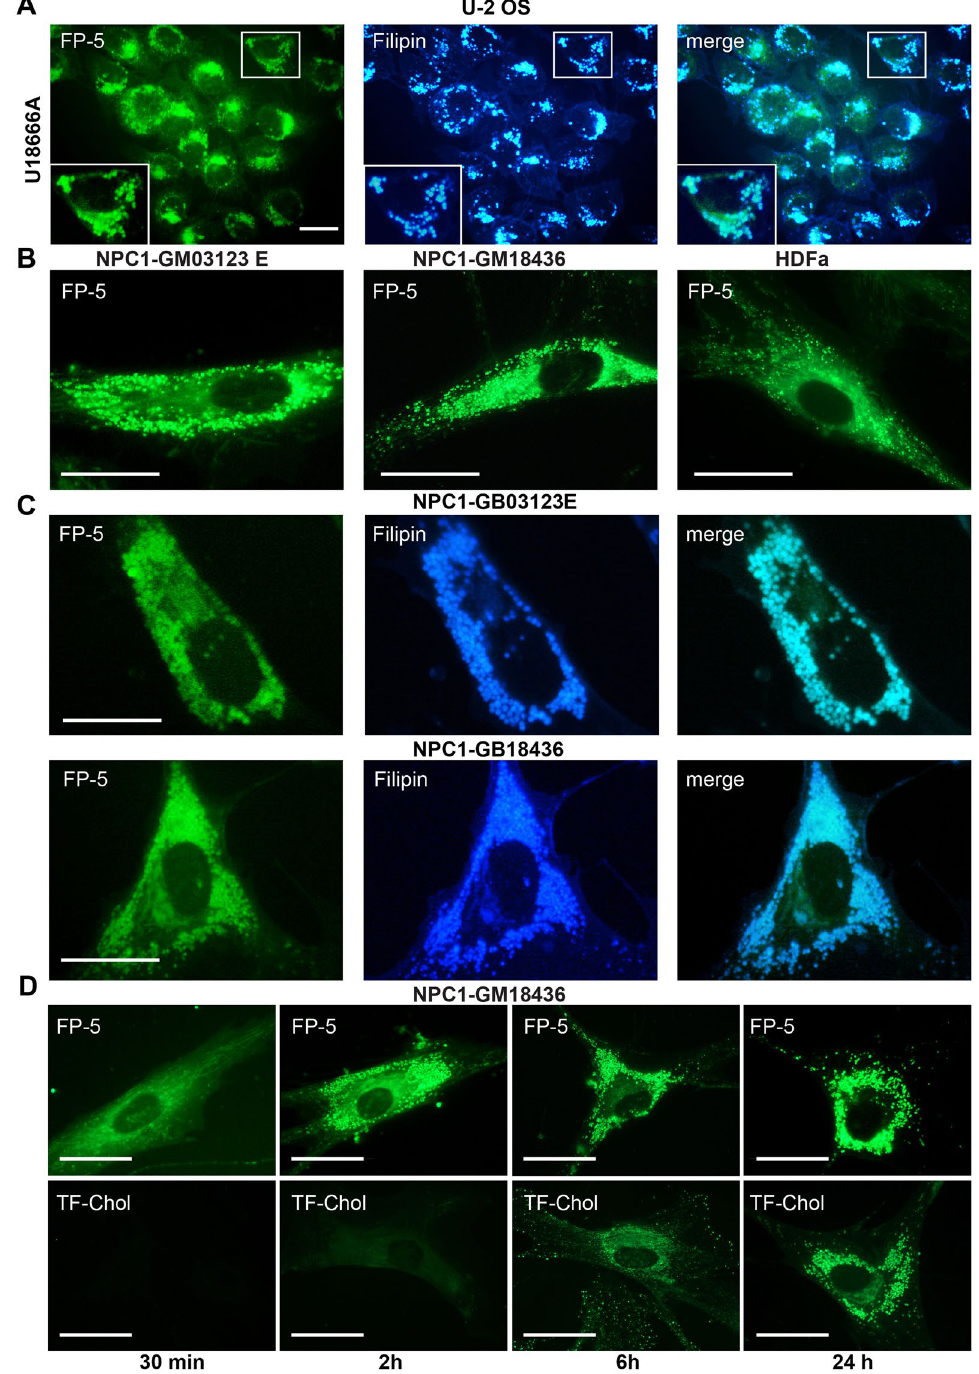
Figure 4. FP-5 fluorescence in cells with abnormal content of cholesterol. ( A ) Cholesterol transport in U-2 OS was inhibited by inhibitor U18666A (1 μ g/ml) for 48 h and then cells were labelled with FP-5 (200 nM) for additional 24 h, fixed and stained with filipin (50 μ g/ml). Expansion of the region indicated by the white box is shown on the low left side. ( B ) Human fibroblasts carrying mutations in NPC1 cholesterol transporter (clones GB03123E, GB18436) and control normal human fibroblasts (HDFa) were labelled with FP-5 (200 nM) for 6 h and examined. ( C ) Co-localization of FP-5 and filipin staining in mutant cell clones. ( D ) Differential kinetics of FP-5 and TF-Chol lysosomal labelling in NPC-GM18436 fibroblasts. Cells were incubated with FP-5 (200 nM) and TF-Chol (1 μ M) for indicated times in medium containing 5% LPDS and imaged live. Scale bar represents 10 μ